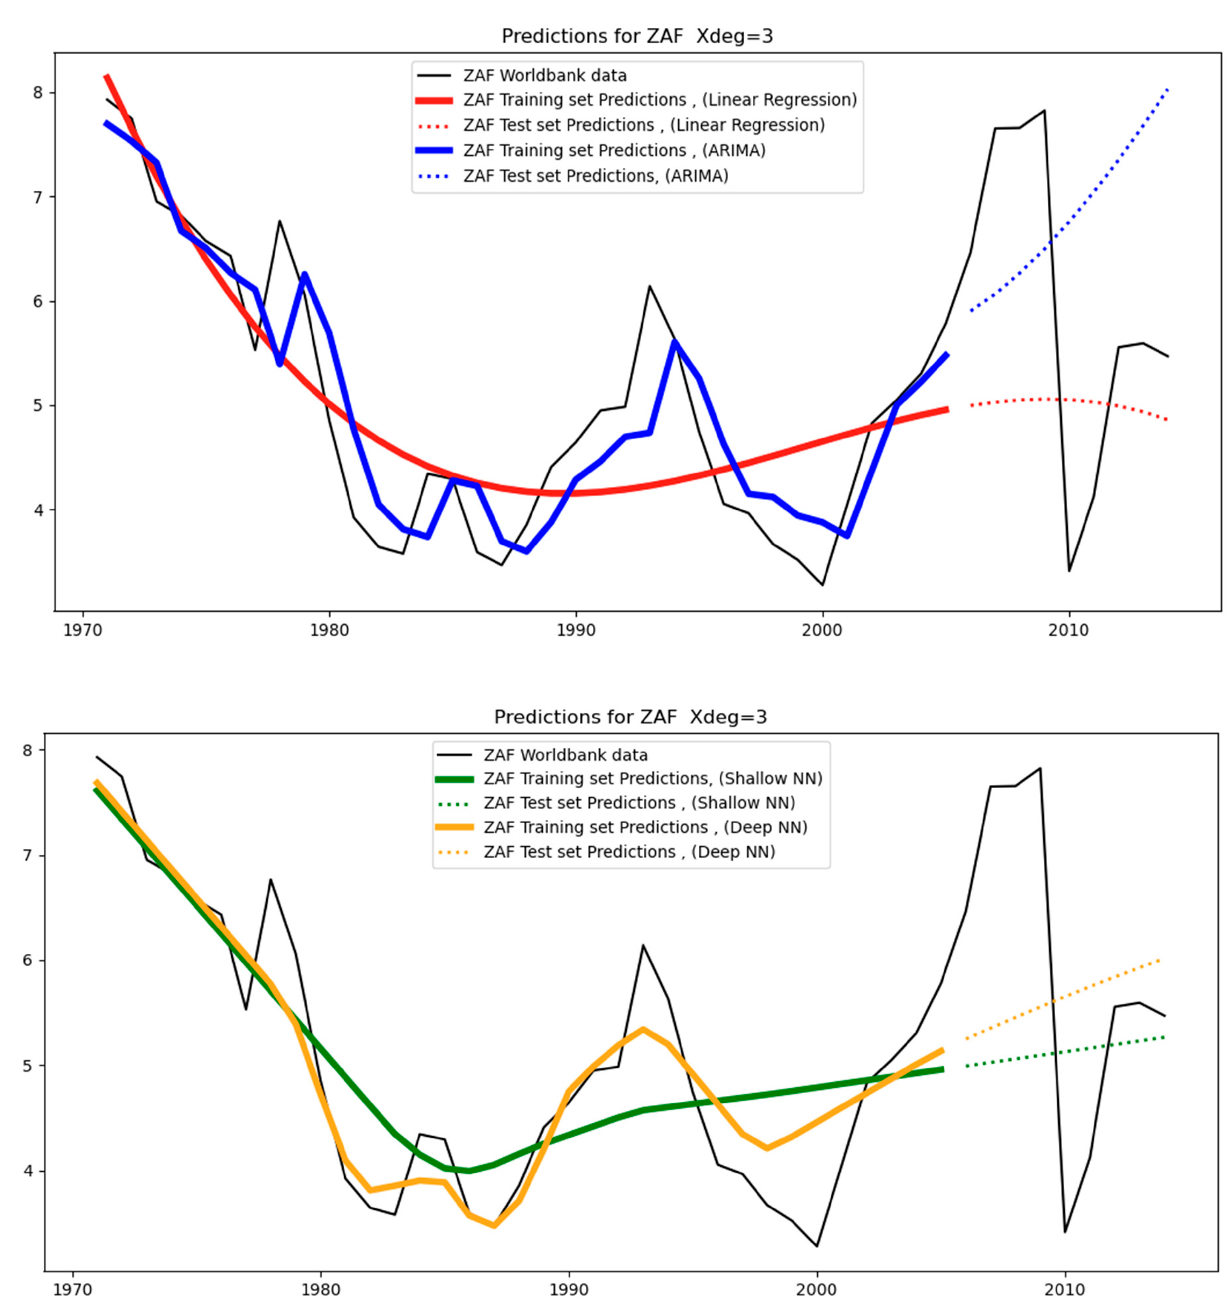
Figure 11. Predictions for South Africa (ZAF), with a third-degree polynomial (Xdeg = 3), are shown for both the training set (periods 1971–2005) and the test set (periods 2006–2014), using linear regression (LR), ARIMA, shallow neural networks, and deep neural network models.